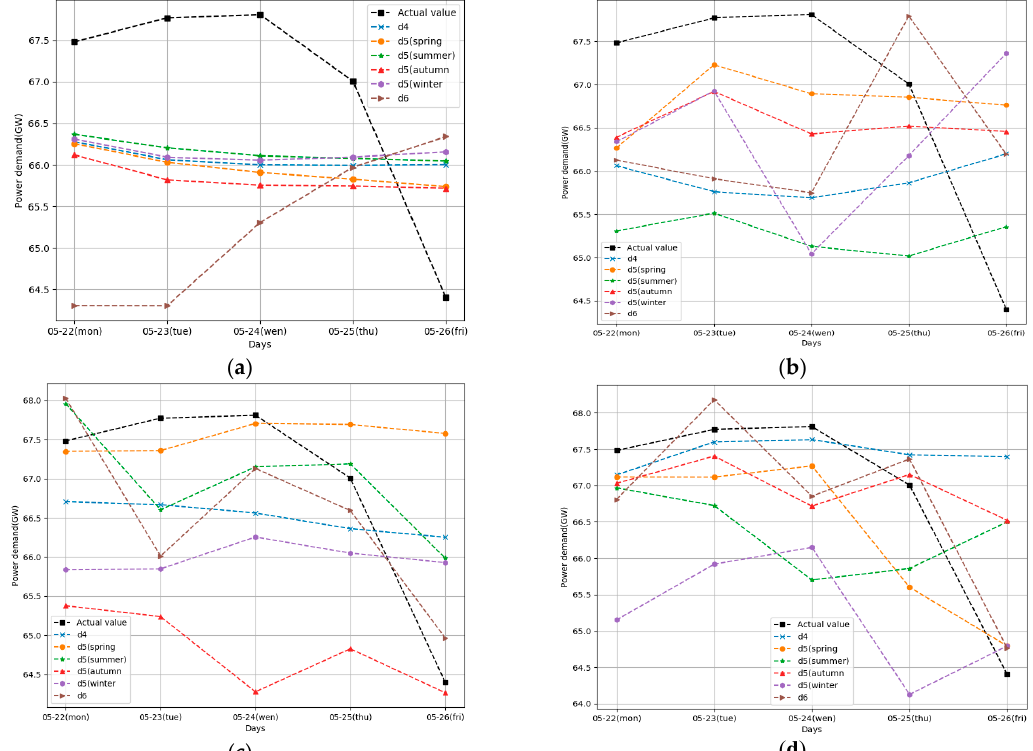
Figure 16. Experimental results by dataset for each model: ( a ) ARIMA; ( b ) ( c , l )-LSTM; ( c ) S2S LSTM; ( d ) ( c , l )-LSTM+CNN.